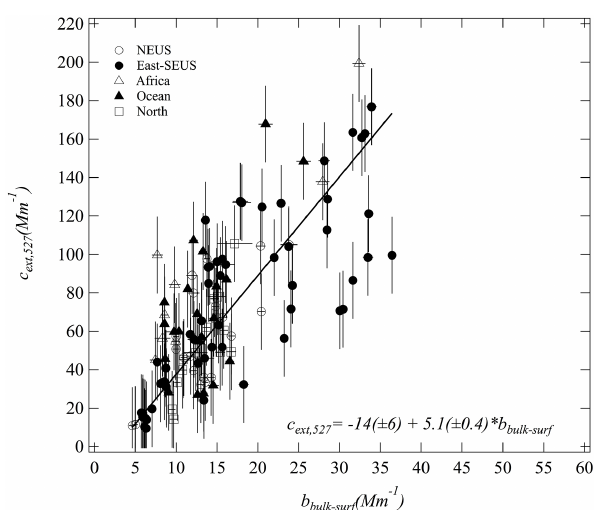
Figure 1. Scatterplot of the hourly averaged daytime extinction coefficient at the lowest height bin retrieved from the MPL data ( c ext , 527 ) vs. the scattering coefficient ( b bulk-surf ). Values in paren- theses in the equation are standard errors and r 2 = 0 . 56. Error bars depict standard deviation for the hourly averaged scattering coef- ficient; for extinction, the approximate uncertainty in the inversion result is shown. The regression is as described in Sect.